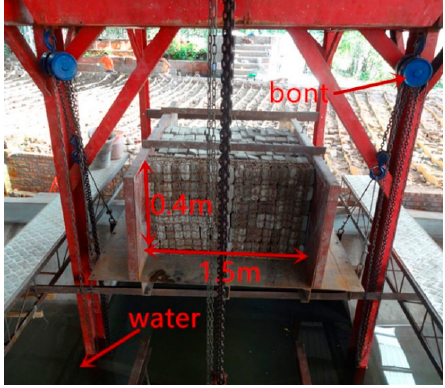
Figure 10. Dimension of the landslide body.